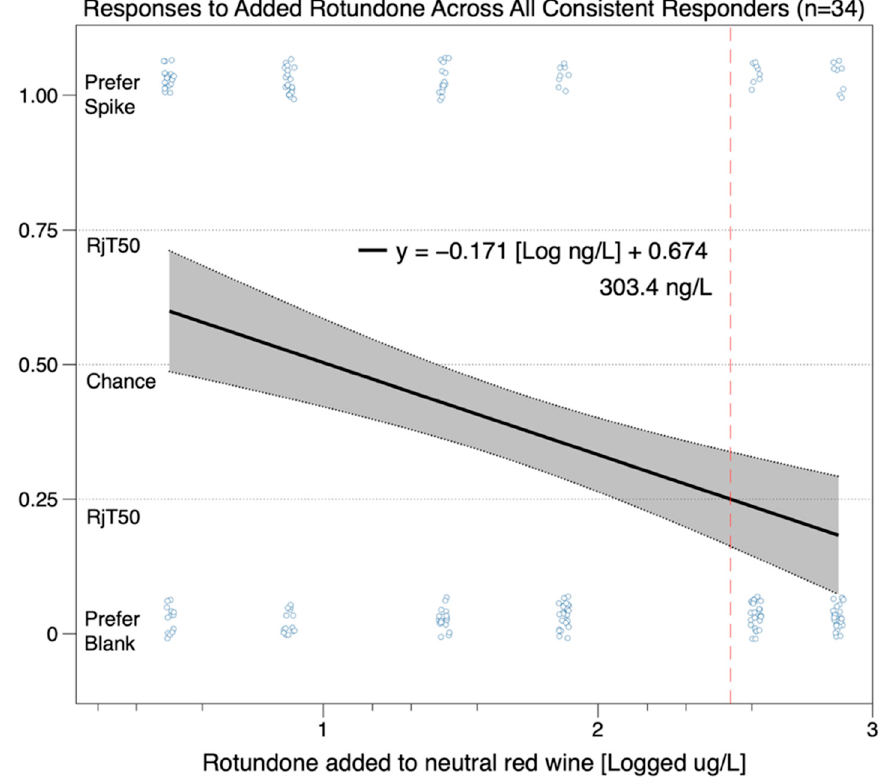
Figure 3. Estimated rejection threshold for all 34 participants who had consistent responses to the top three rotundone concentrations (75 ng/L, 375 ng/L, and 750 ng/L) added to red wine.